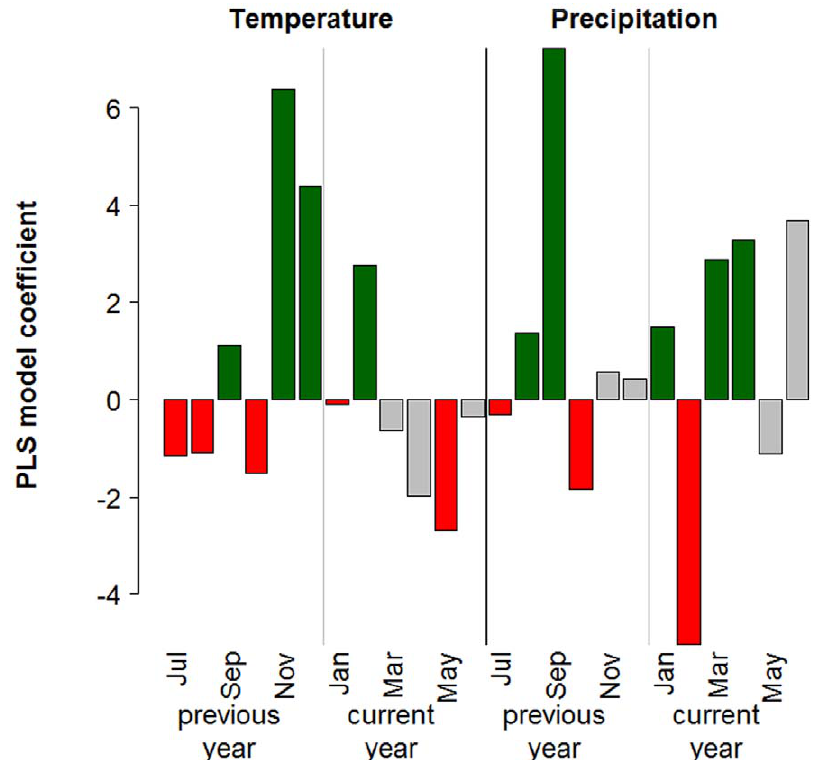
Figure 7. Results from Partial Least Squares regression analysis for one pixel of the analysis grid, showing results for the beginning of the growing season (BGS). Green bars indicate variables, for which a positive correlation with late BGS dates was determined (possibly indicating a delaying effect of high temperatures or precipitation during this month). Red bars indicate a negative correlation (indicating an advancing effect of high temperatures or rainfall). Gray bars are drawn for variables, for which the variable-importance-in-the-projection score was , 0.8, indicating that the variable is not important. This color scheme is used for all subsequent maps.